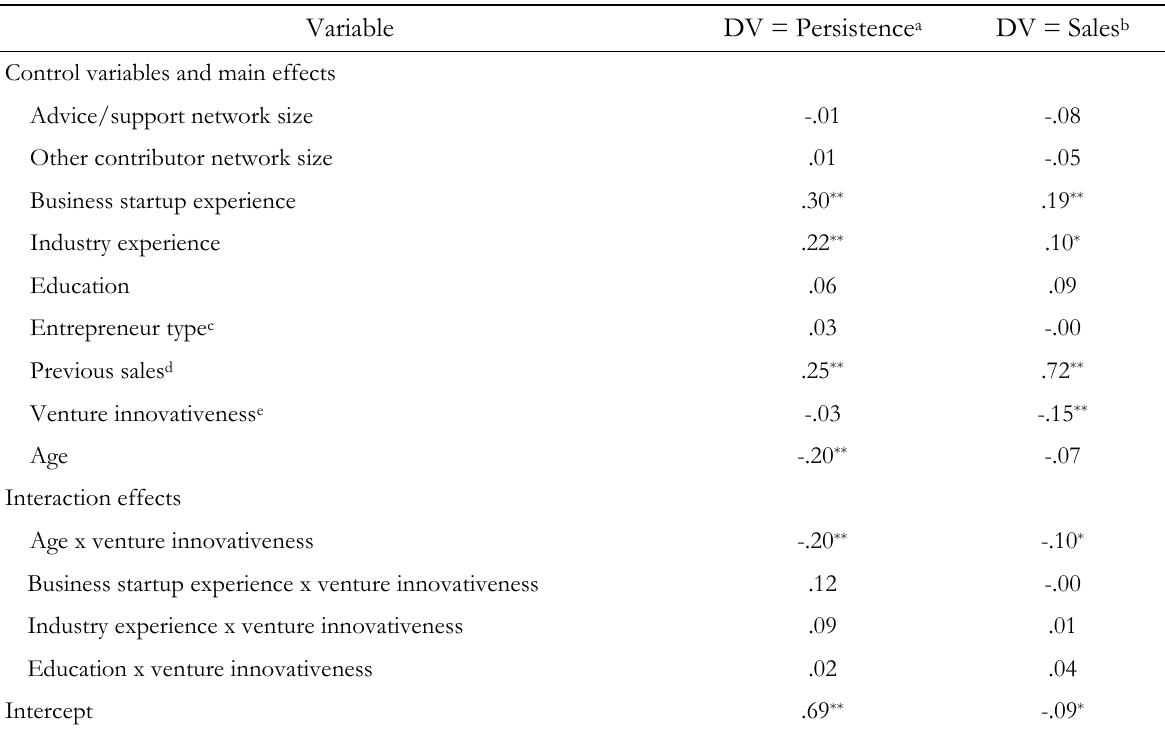
Table 3. GEE Results for the Moderating Effect of Venture Innovativeness on the Relationship between All Entrepreneur Characteristics and Venture Performance (Post-hoc Analysis